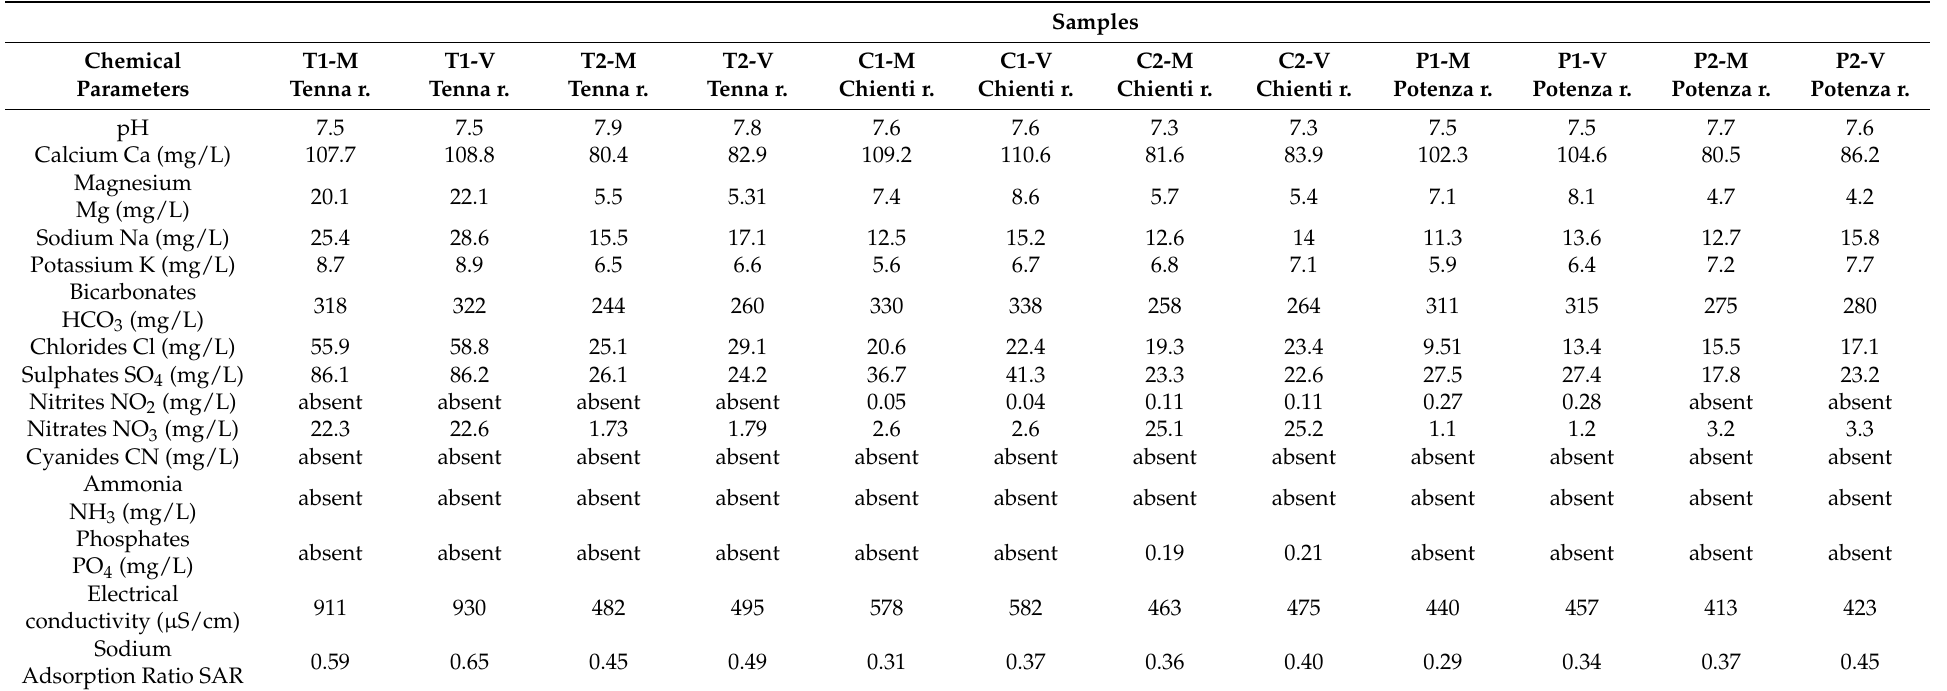
Table 1. Results of the chemical analyses carried out on the 12 samples of water taken in correspondence with the sample